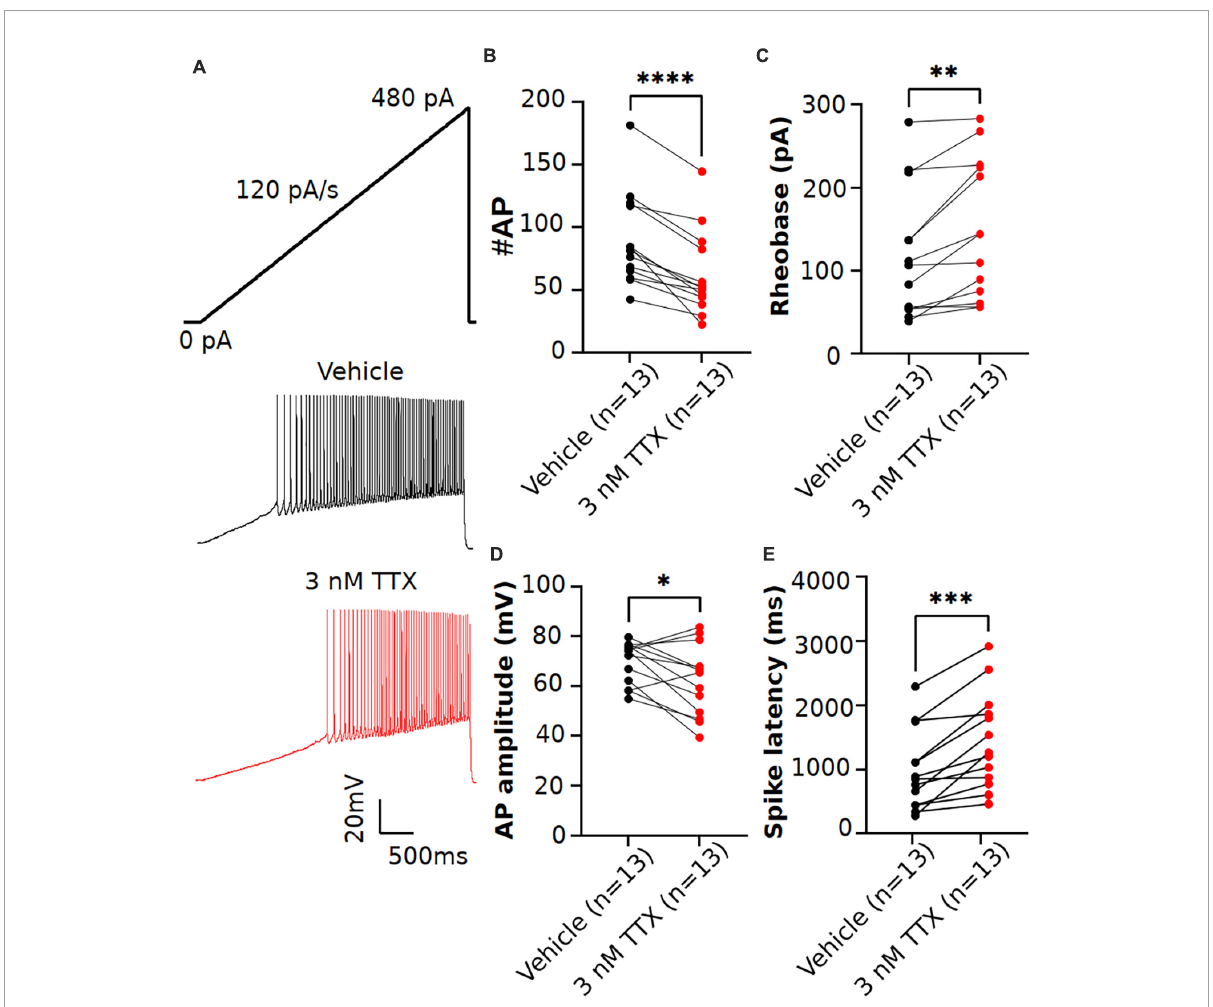
FIGURE4 Effects of low concentration of TTX on intrinsic excitability of pyramidal neurons using a current ramp injection. (A) Representative voltage traces of pyramidal neurons recorded in response to a current injection ramp (4 s ramp from 0 pA to 480 pA; 120 pA/s) without (black) and with (red) application of 3 nM TTX. (B) Scatter plot showing significant impact on the number of APs with application of 3 nM TTX. (C–E) Using this protocol, we found that the rheobase (C) , AP amplitude (D) and spike latency (E) was also significantly altered with application of 3 nM TTX (paired 2 tailed t -test, ∗ p < 0.05, ∗∗ p < 0.01, ∗∗∗ p < 0.001, ∗∗∗∗ p < 0.0001, n = 13